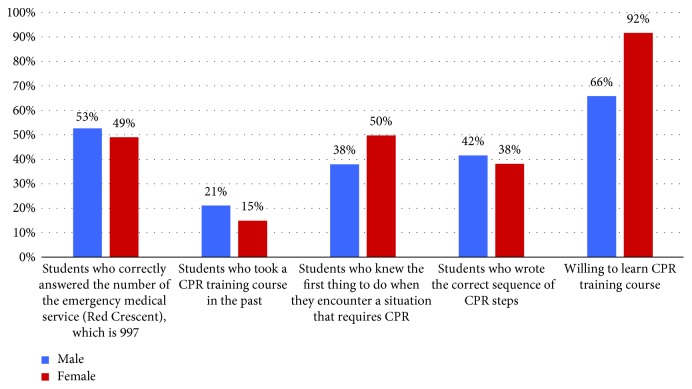
Comparison between both genders.